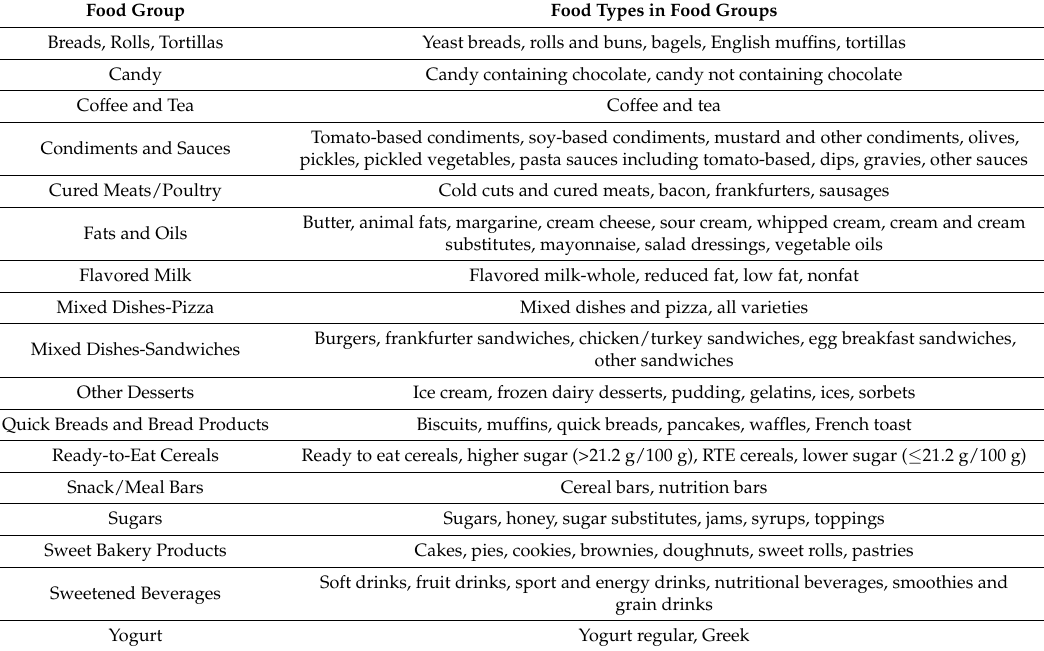
Table 1. Breakdown of food groups that contribute to intakes of added sugars determined by What We Eat in America